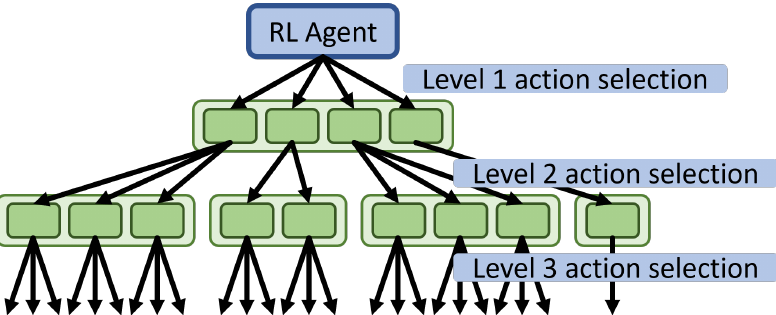
Figure 12. Diagram of the hierarchical structure of a parameterized action space. There is a layer for each discrete decision being made with the final layer containing the values of the continuous action(s) desired by the agent. The number of continuous action outputs can vary depending on the discrete decision